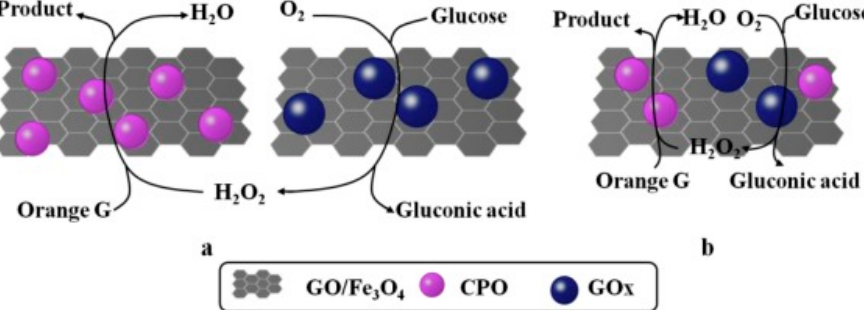
Figure 2. ( a ) Mass transfer resistance between chloroperoxidase (CPO) and glucose oxidase (GOx) for MGO-GOx+MGO-CPO; ( b ) no mass transfer resistance between CPO and GOx for MGO-GOx-CPO. Reprinted from Gao et al. [19], with permission from Elsevier. Copyright (2018) Elsevier